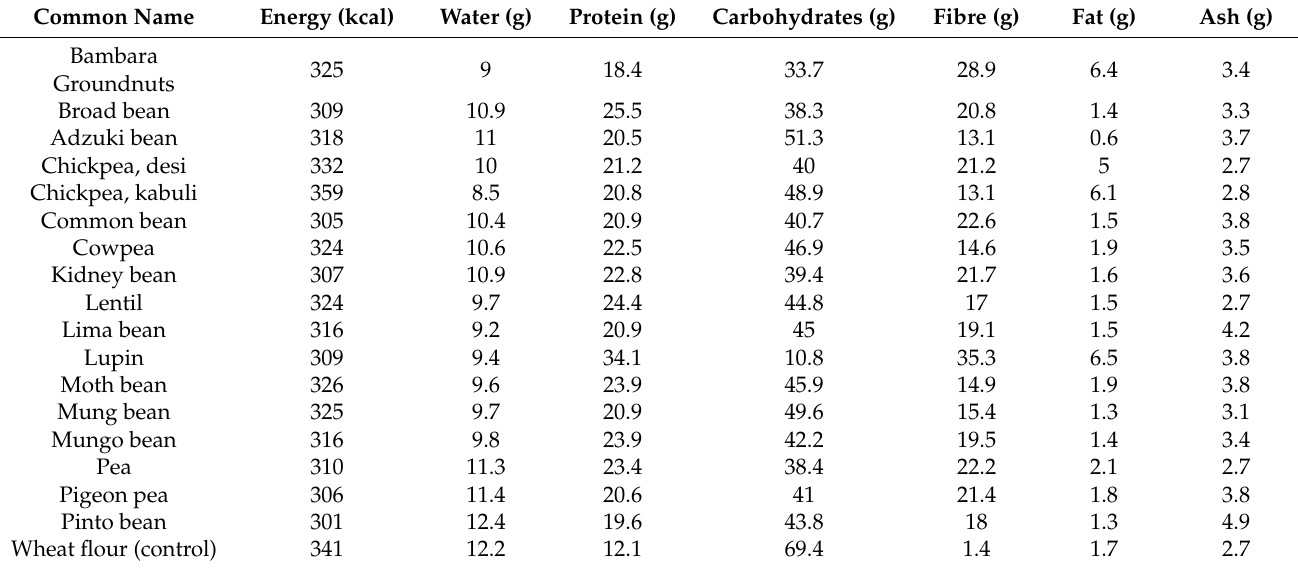
Table 2. Energy and macro-components of mature, whole, dried, raw pulses (expressed per 100 g edible portion on a dry matter